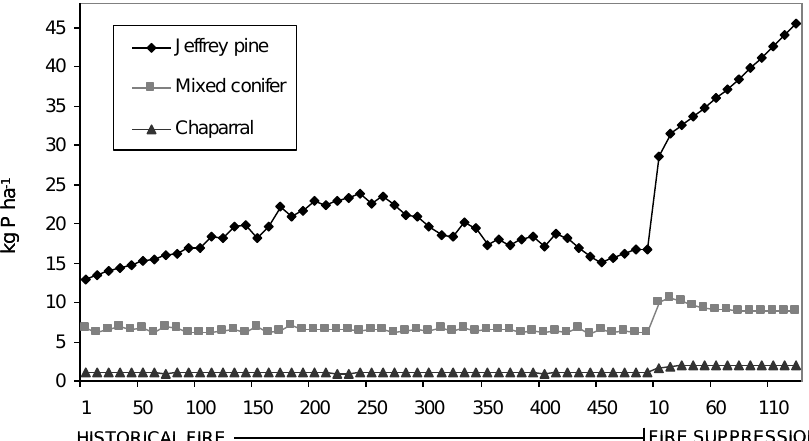
Figure 3. Average modeled litter P contents for each PNV type for 500 years of historical fire and 130 years of fire suppression.